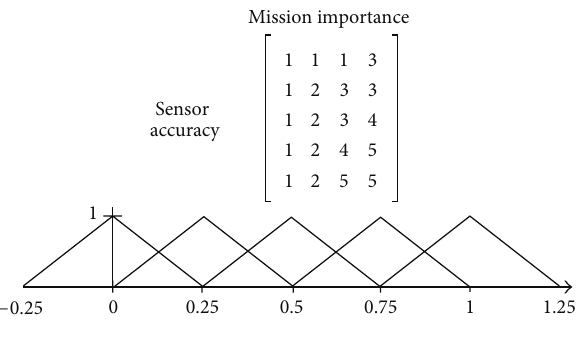
Figure 9: The inference engine of the sensor capability and mission importance creates the relationship between the consequent mem- bership functions and the antecedent membership function for both classification and kinematic capabilities of the sensors.